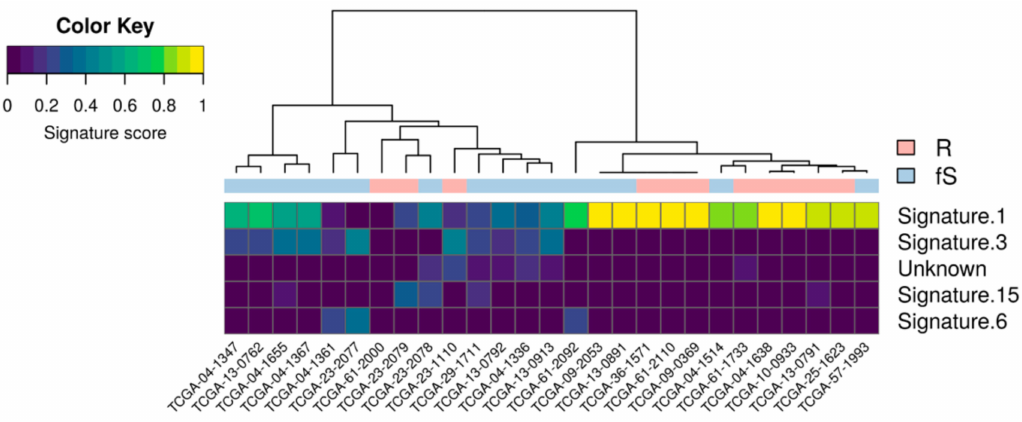
Figure 2. Mutational signatures in TCGA-OV27 cohort. Heatmap showing the contribution of the top-5 most represented COSMIC signatures in the mutational profiles of TCGA-OV27